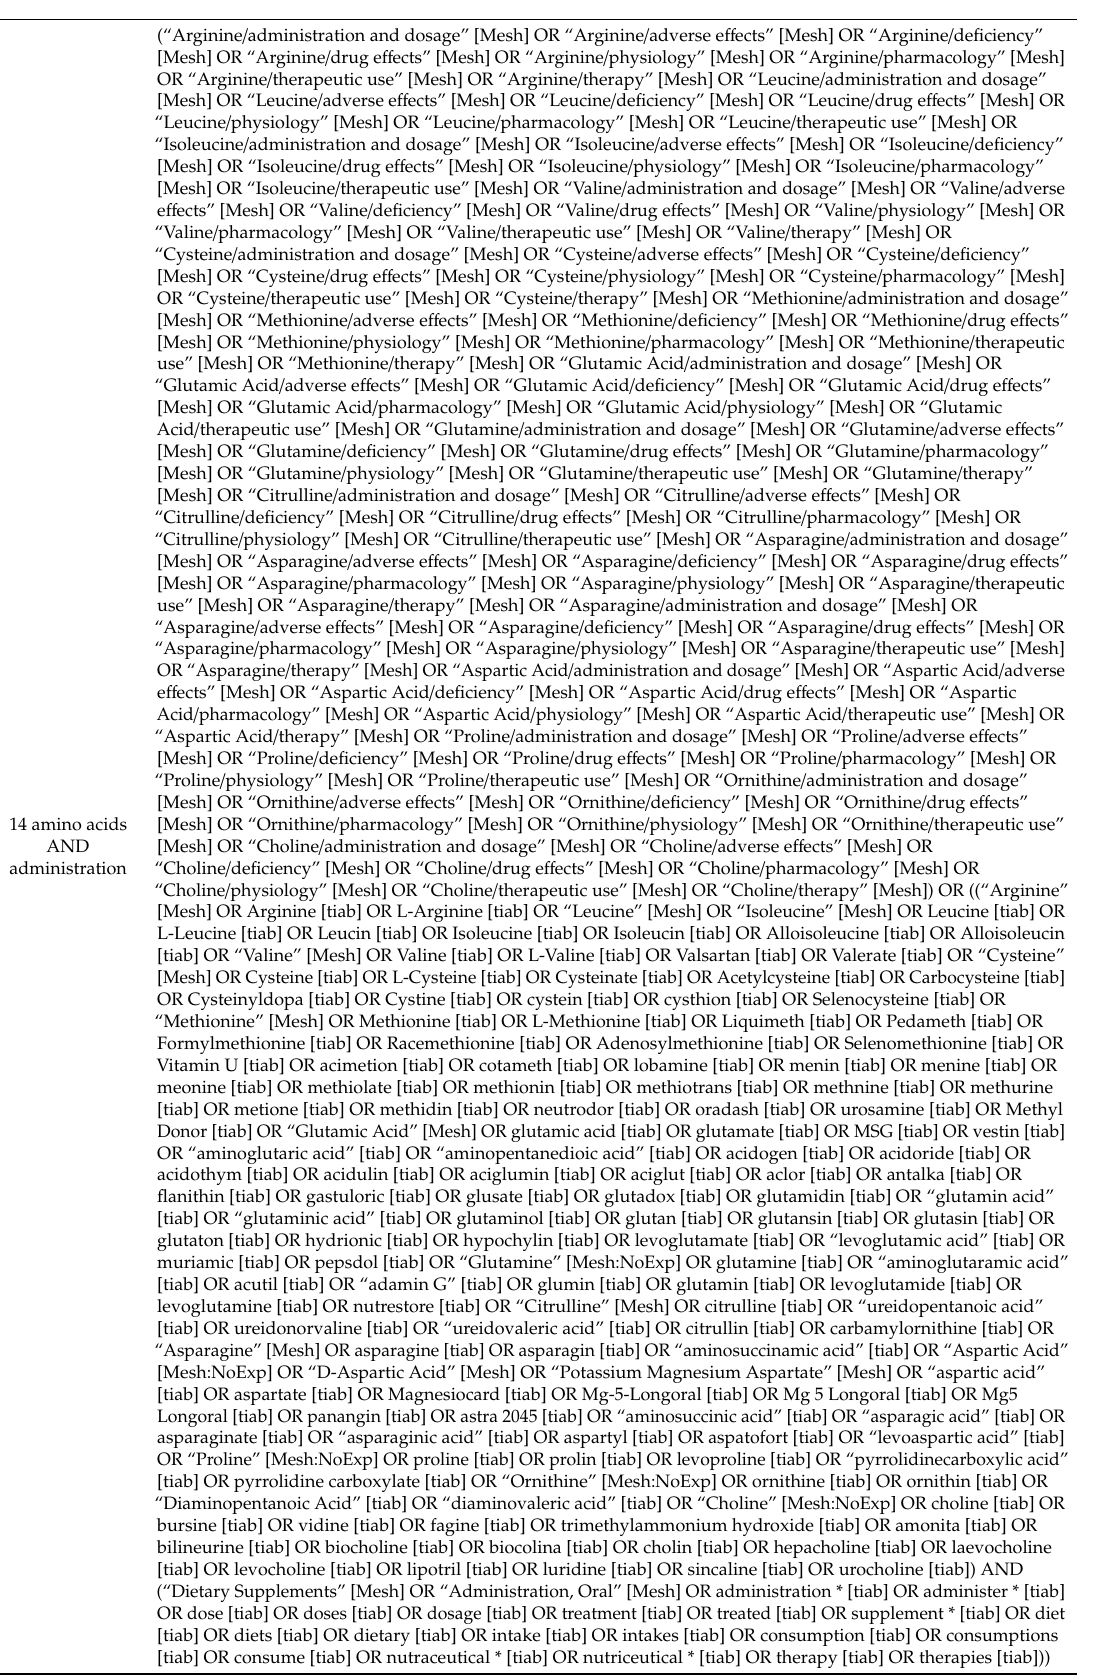
Table A1. Search terms in